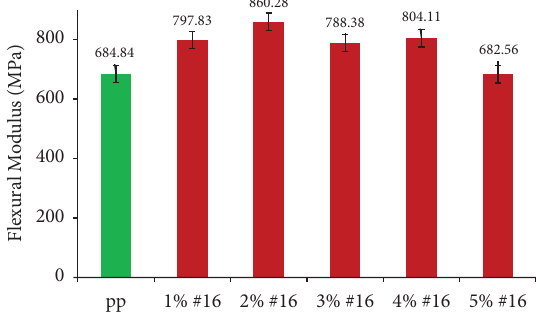
Figure 2: Elastic modulus for pure PP and #16 samples.